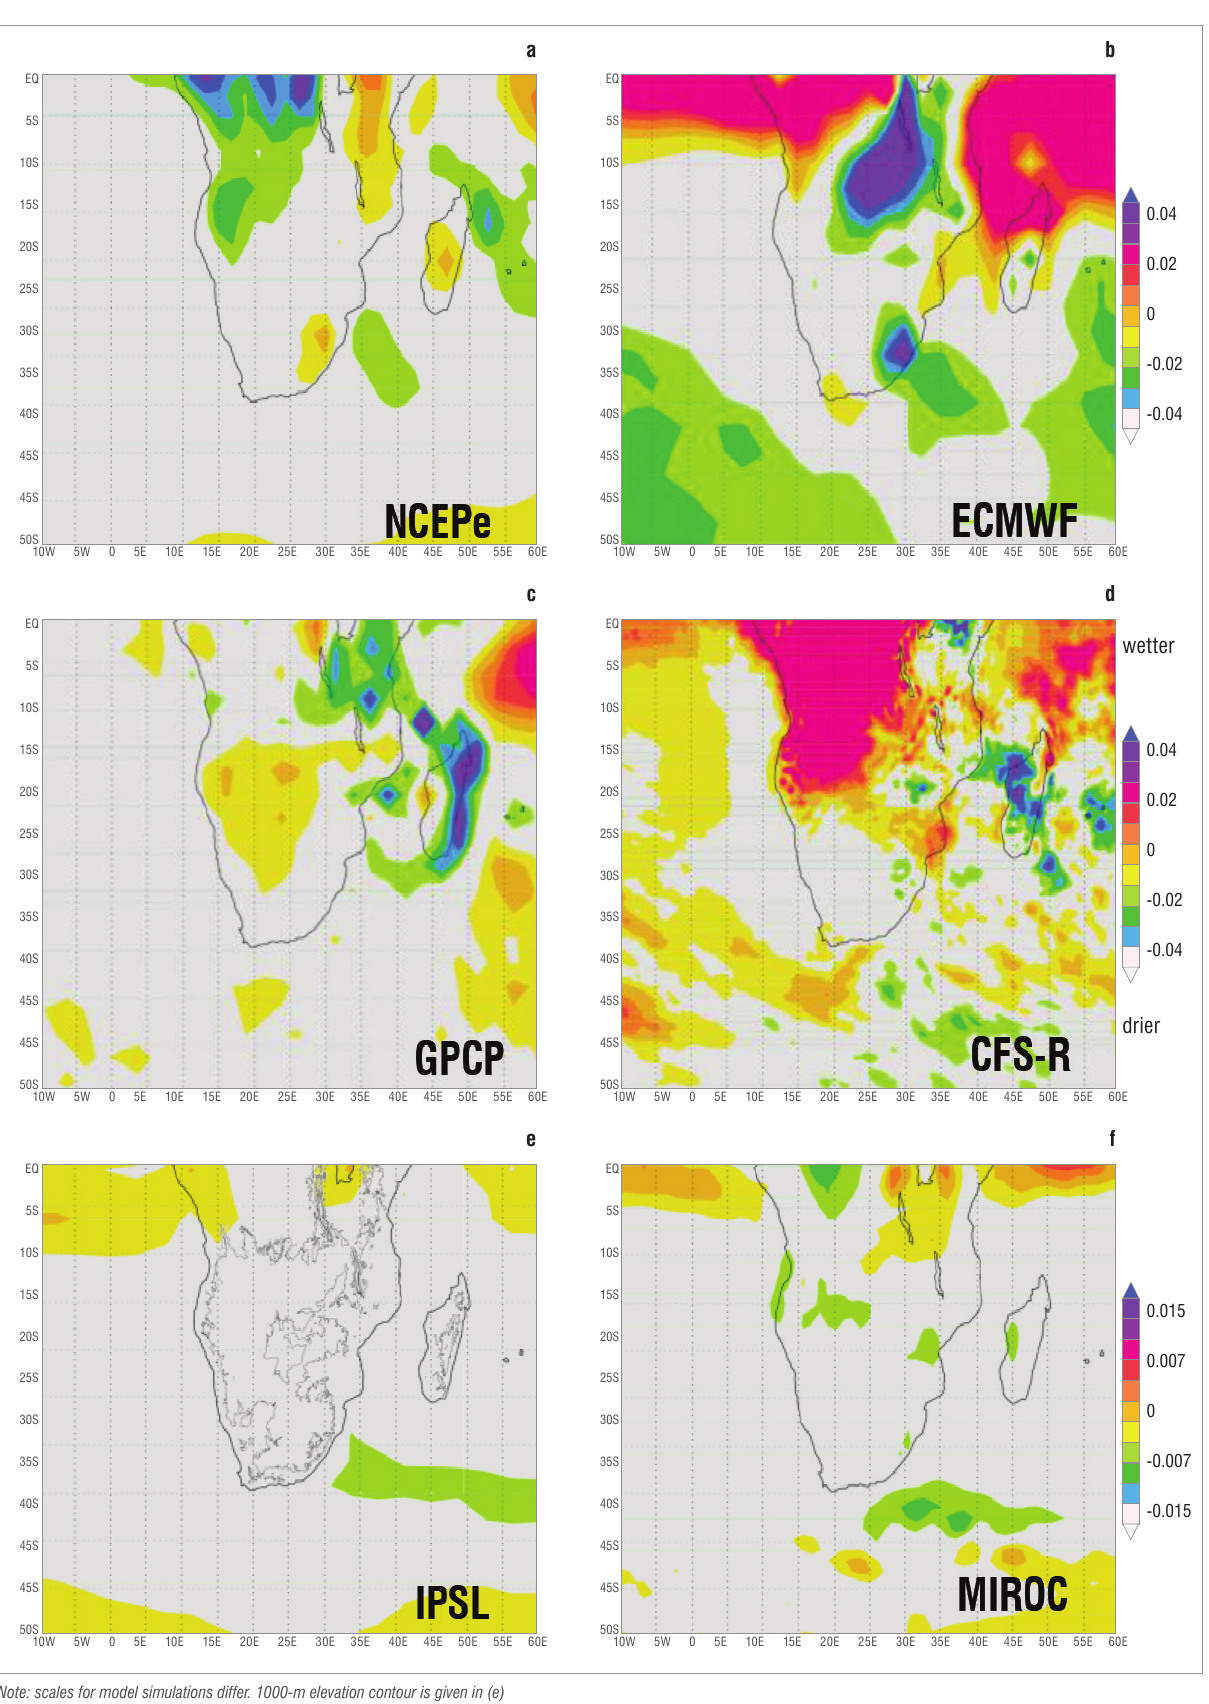
Note: scales for model simulations differ. 1000-m elevation contour is given in (e) Figure 3: Rainfall trends (mm/day per year) over southern Africa obtained through linear regression for (a) 1900–2010, (b) 1958+, (c and d) 1979+, and (e and f)